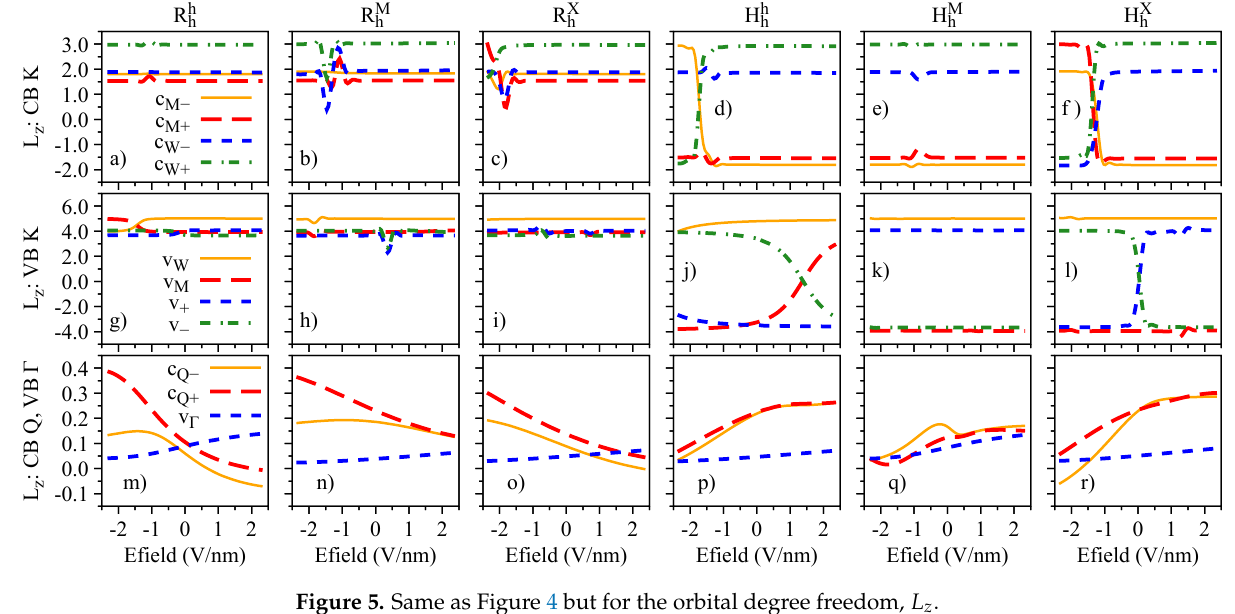
Figure 5. Same as Figure 4 but for the orbital degree freedom, L z .